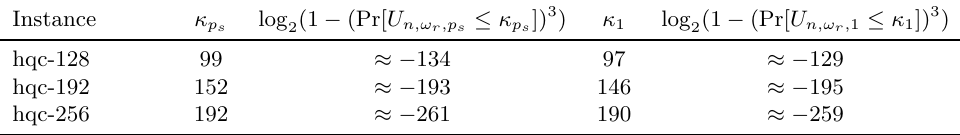
Table 6: Number of indices κ that must be derivable from the generated randomness reservoir to achieve a probability on the order of the security parameter of a message emitting multiple seedexpander calls. Here, p is set to (cid:4) 2 k /m (cid:5) m/ 2 k for when the original s rejection sampling is used or 1 when the bit position sampling cannot fail due to the use of the constant-time random number generation